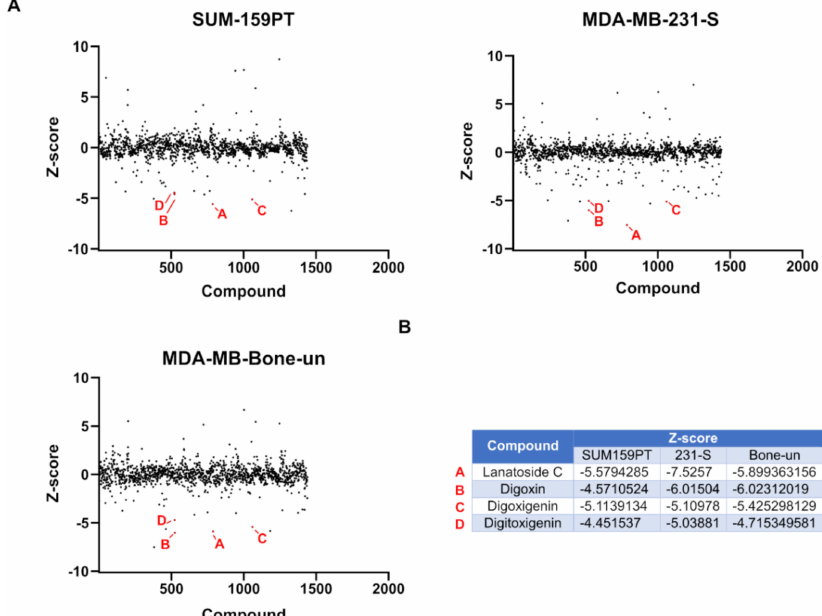
Figure 2. Prestwick Chemical Library Screen. ( A ). Z-scores for each compound from the Prestwick Chemical Library were calculated for their ability to reduce expression levels of (CGG) 4 Luc2-tdTomato in MDA-MB-231-S, MDA-MB-Bone-un, and SUM-159PT cells ( n = 1). ( B ). Individual Z-scores of lanatoside C, digoxin, digoxigenin, and digitoxigenin from each cell